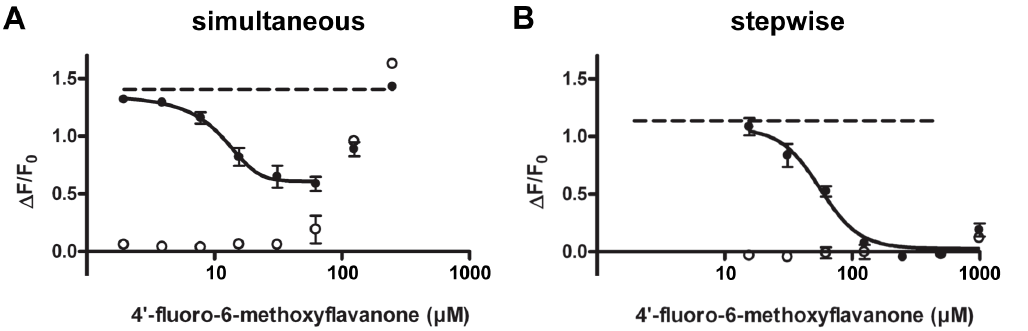
N # )) by 4 9 -fluoro-6-